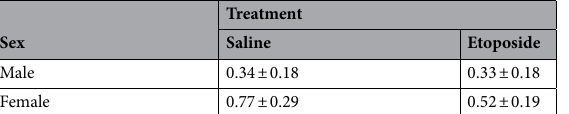
Table 2. γH2Ax foci normalized to DAPI area (μm) in the CA1 region of animals that were euthanized 15 min after the last contextual recall test. Data presented as averages ±